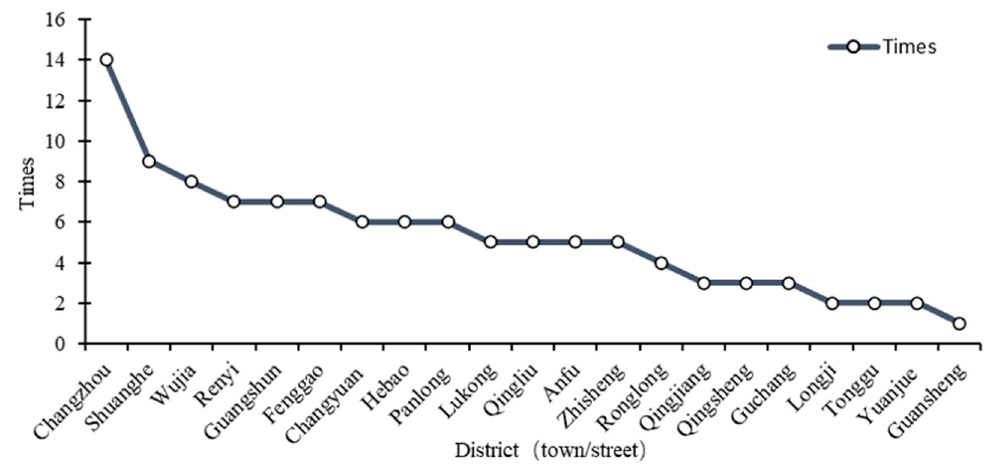
Figure 5. Adjustment frequency of general land-use planning in Rongchang District from 2013 to 2015.